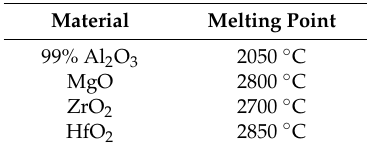
Table 1. Anti-oxidation ceramic with melting point.